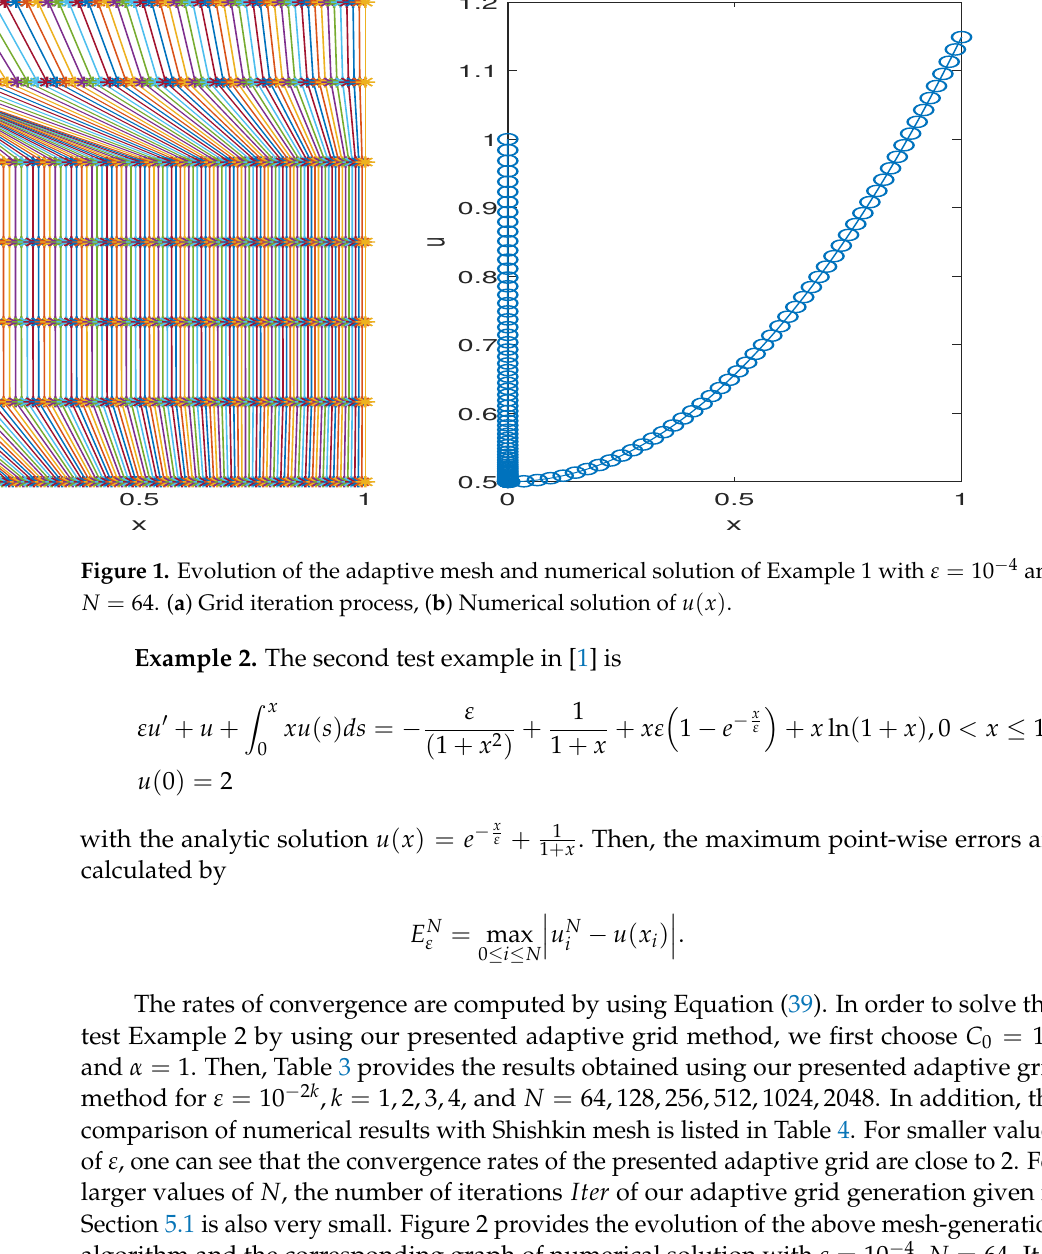
9 of 12 Table 2. Comparison of numerical results with Shishkin mesh for Example 1. N